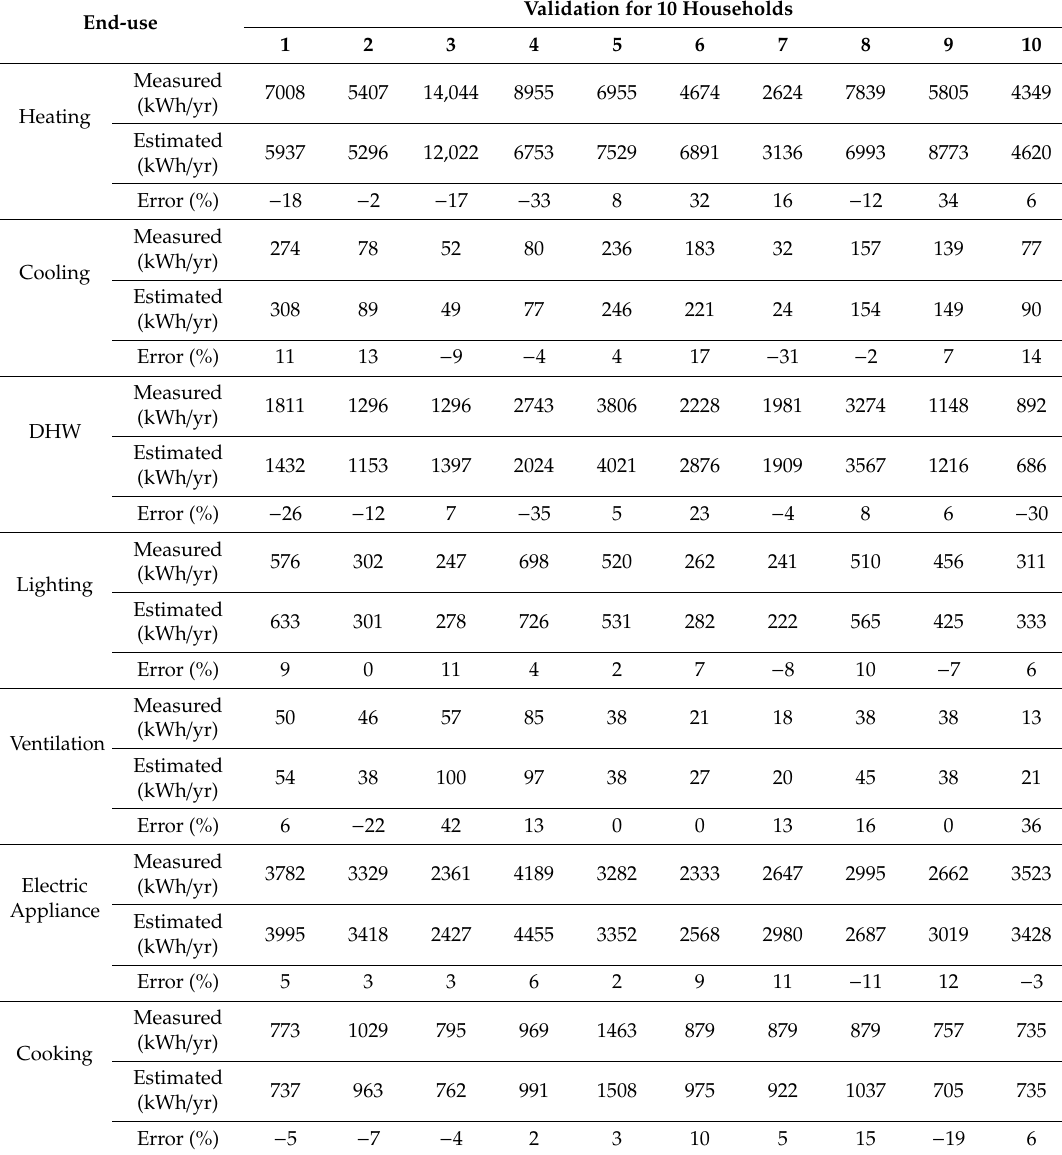
Table 7. Validation of the estimation model with measured